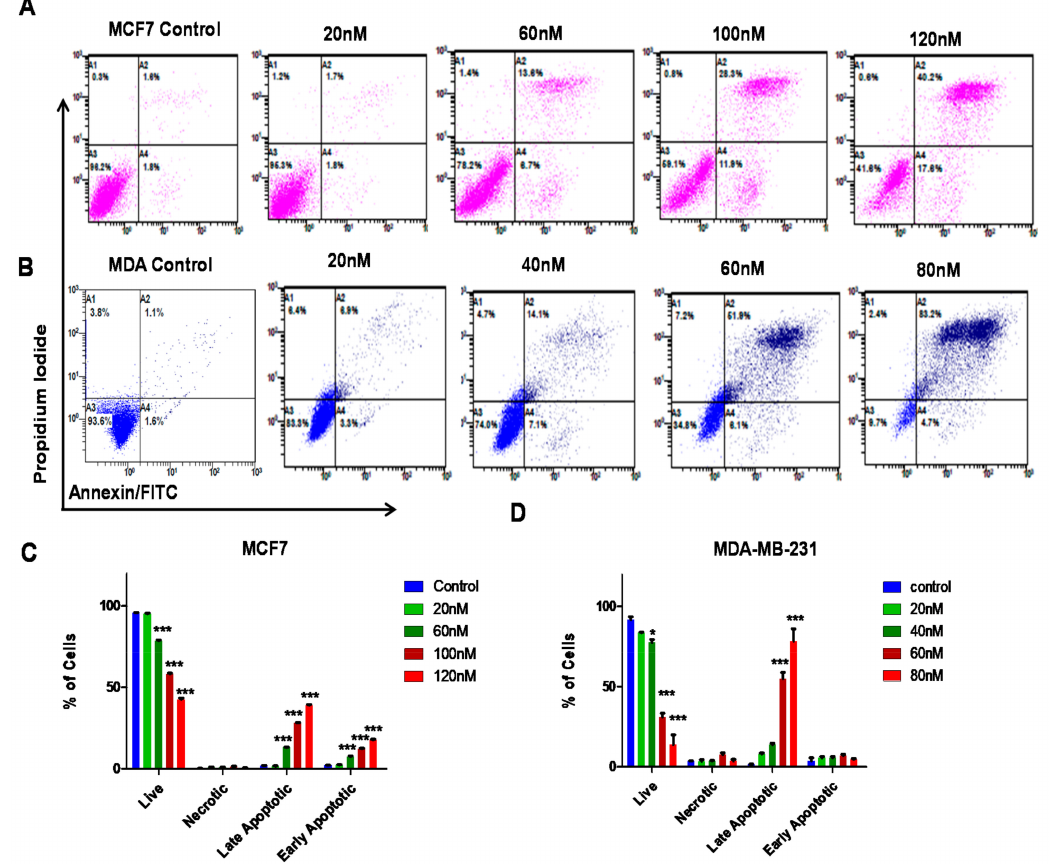
Figure 4. Evaluation of ST09 induced cytotoxicity on breast cancer cells by annexin-FITC / PI double staining: dot plot depicting MCF7 ( A ) and MDA-MB-231 ( B ) cells treated with ST09 (20, 40, 60, 80, 100, 120 nM) for 48 h. Quantification of MCF7 ( C ) and MDA-MB-231 ( D ) apoptotic cells. The